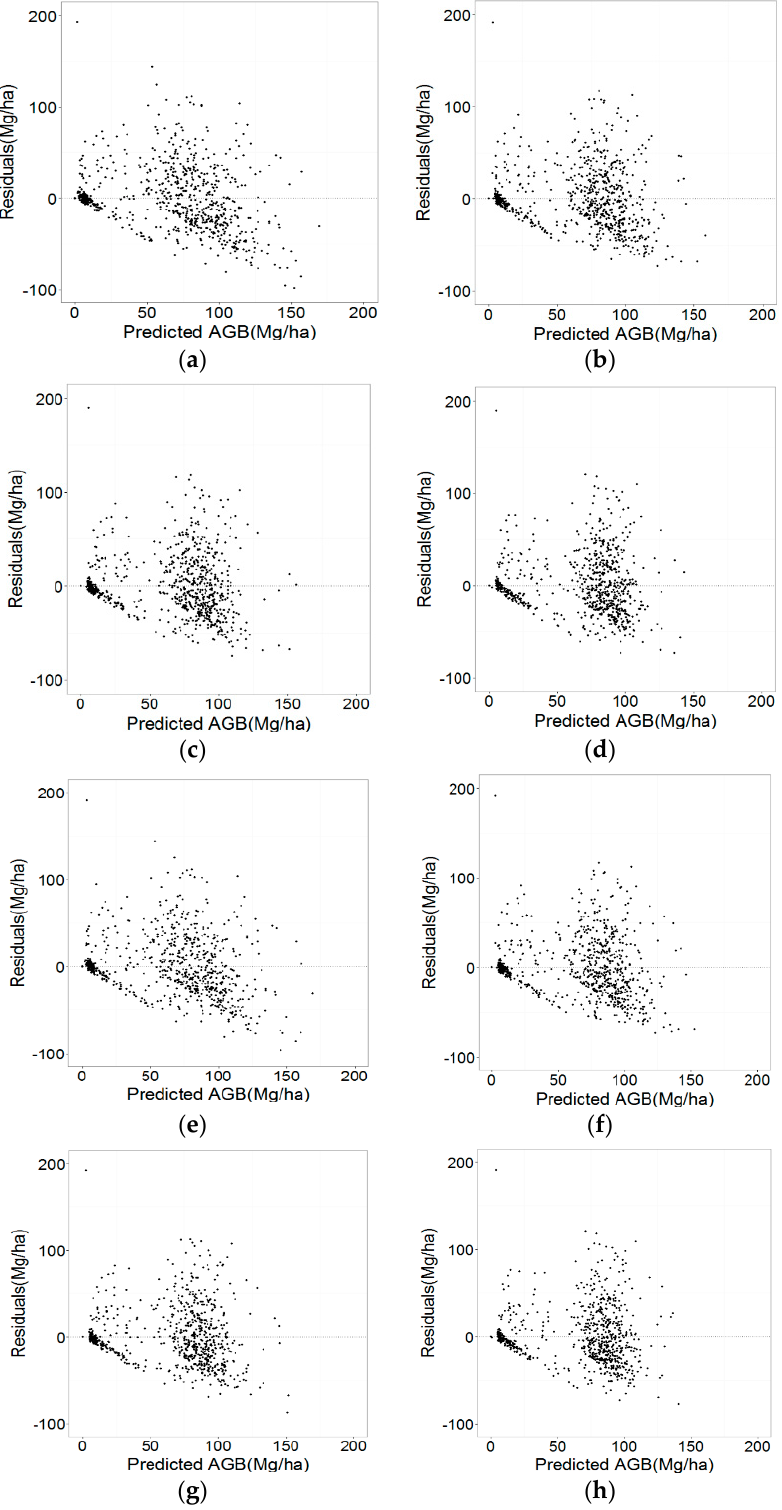
Figure A2. Distributions of residuals for predictions of sample plot AGB using g-kNN algorithm with k values: ( a ) 3; ( b ) 5; ( c ) 7; and ( d ) 10; and CW-kNN algorithm with k values: ( e ) 3; ( f ) 5; ( g ) 7; and ( h ) 10.